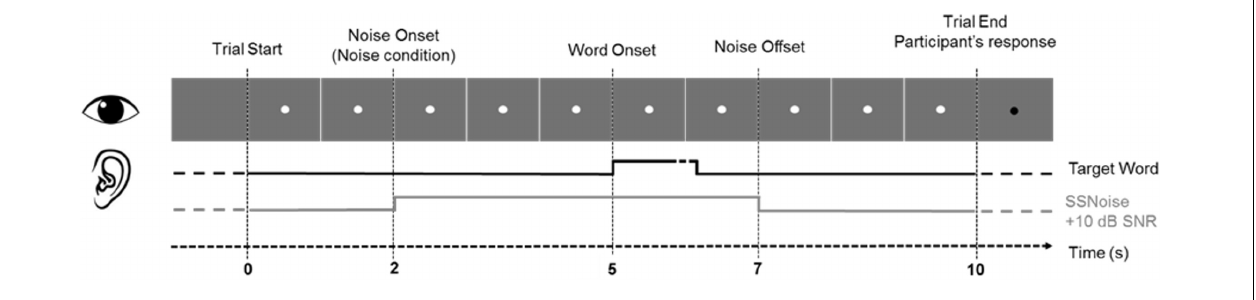
FIGURE 1 | General trial structure and timing of